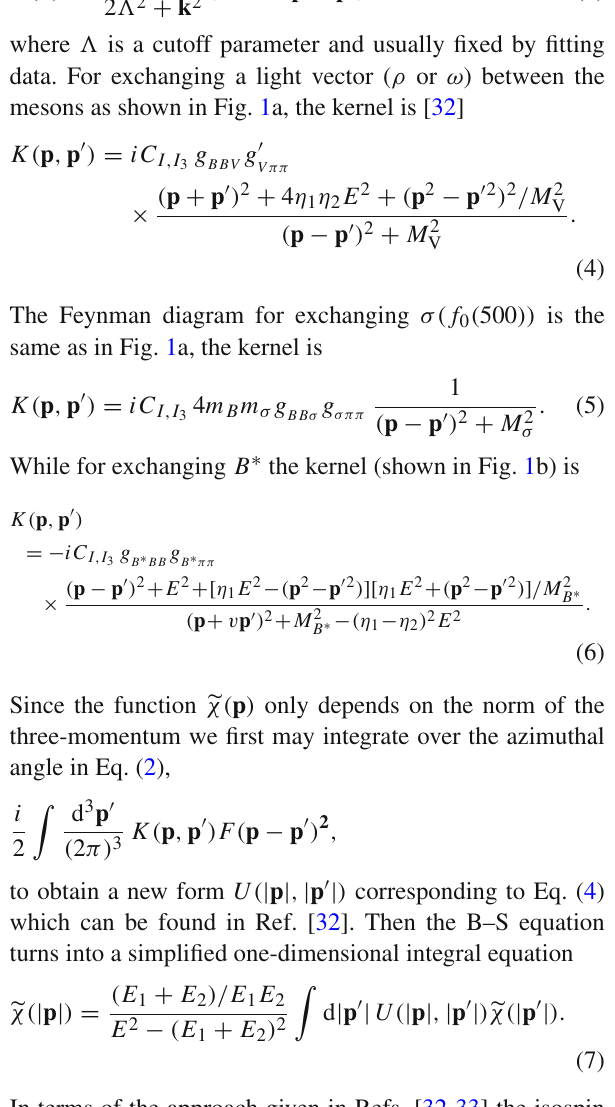
2 (cid:2) 2 − M 2 F ( k ) =